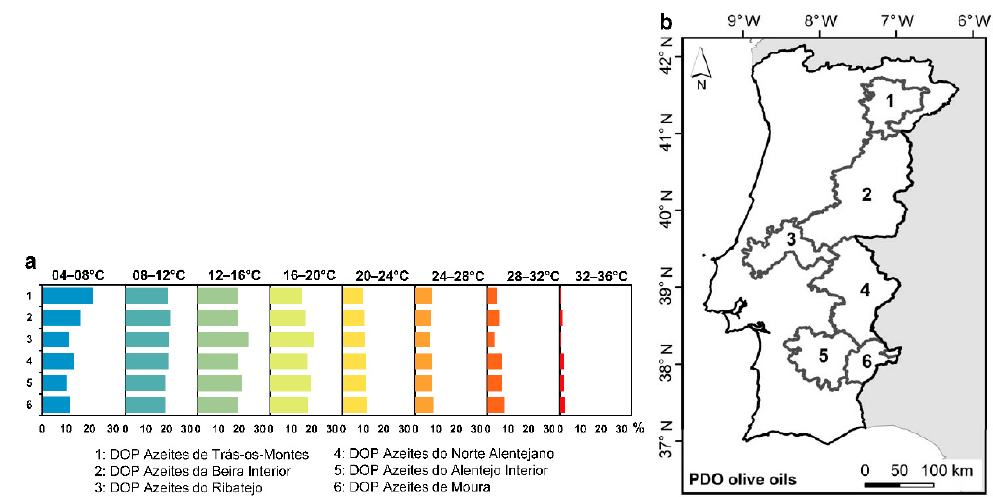
Figure 9. ( a ) Relative bar chart (in %) for the number of hours by different temperature intervals and for each Protected Designation of Origin (PDO) of olive oil. ( b ) Geographical location of the PDO of olive oil (see the list for their designations). Area-means are computed only over the olive tree land cover areas (source: COS2007).